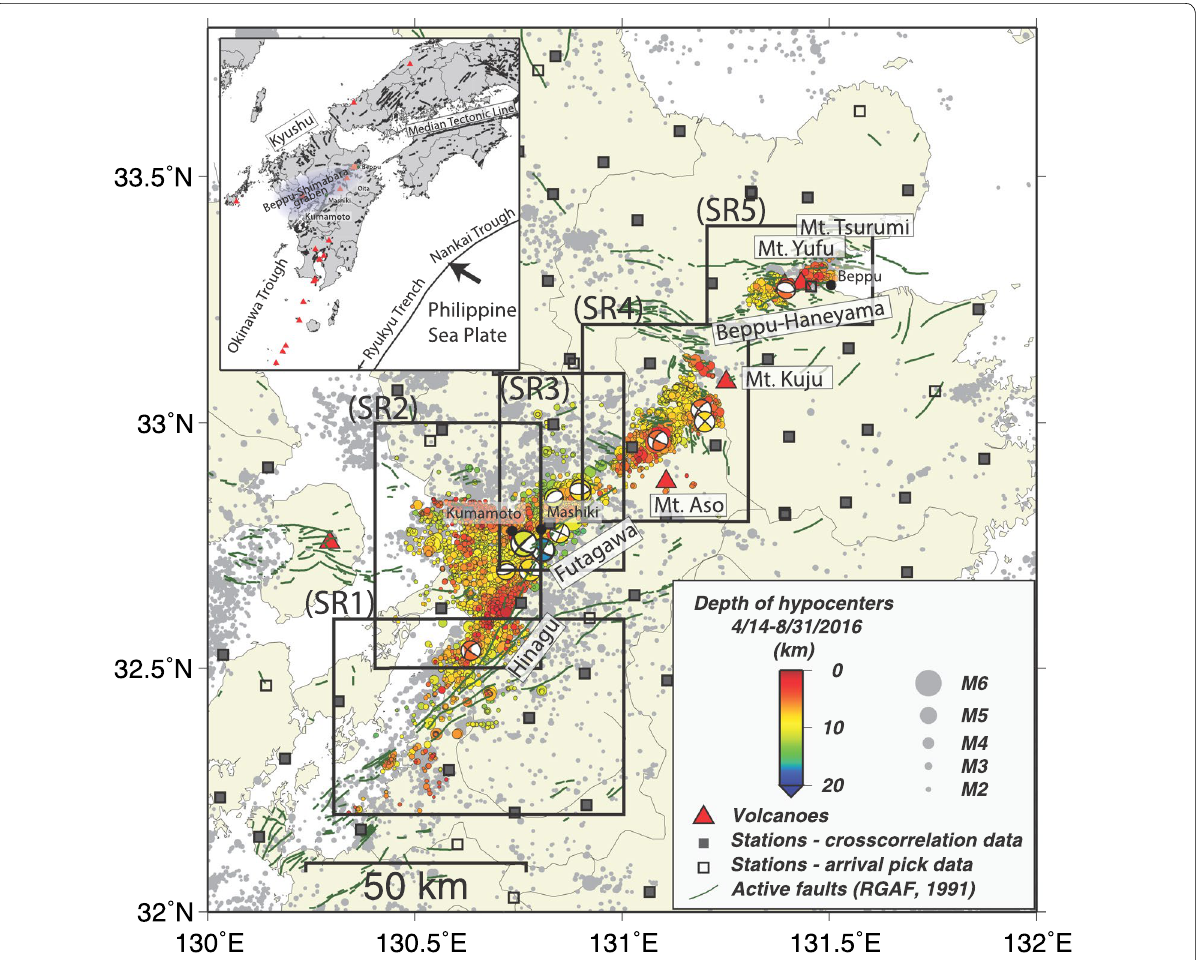
Fig. 1 Map of epicentral distribution relocated using hypoDD and station distribution: gray and colored circles denote the seismicity during 2000–2012 and April 14, 2016–August 31, 2016, respectively. Because the completeness of magnitude for the entire study region went up to a maximum of M Hi-net 1.0 during the 2016 Kumamoto Earthquake sequence (Additional file 1: Figure S4), only events with M Hi-net 1.0 or greater were included in this paper and figures. The F-net CMT solution is indicated in this figure. Active faults are indicated as dark green lines (Research Group for Active Faults of Japan (RGAFJ)